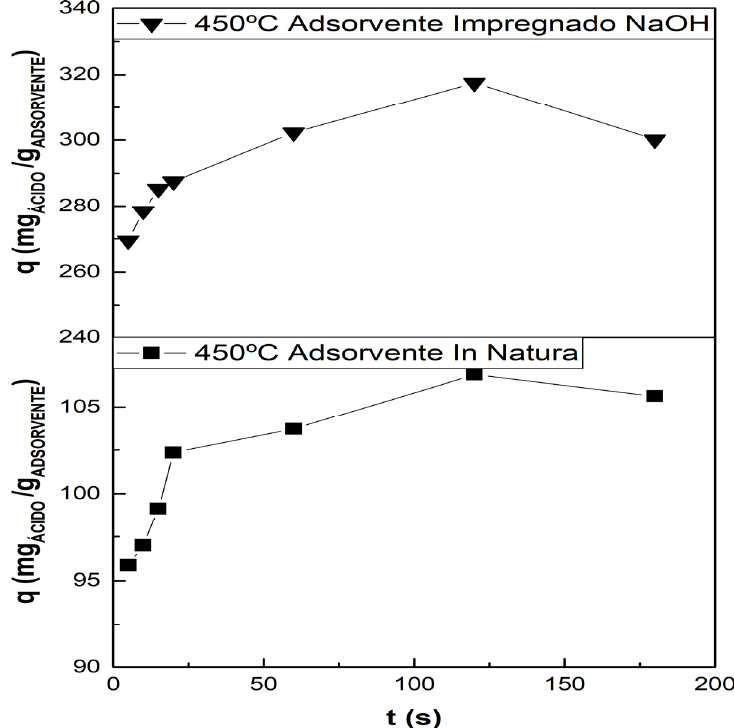
Figure 9. Equilibrium Time Chart of the kinetic assay of açaí seed in nature and impregnated at a temperature of 450 °C. temperature of 450 ◦